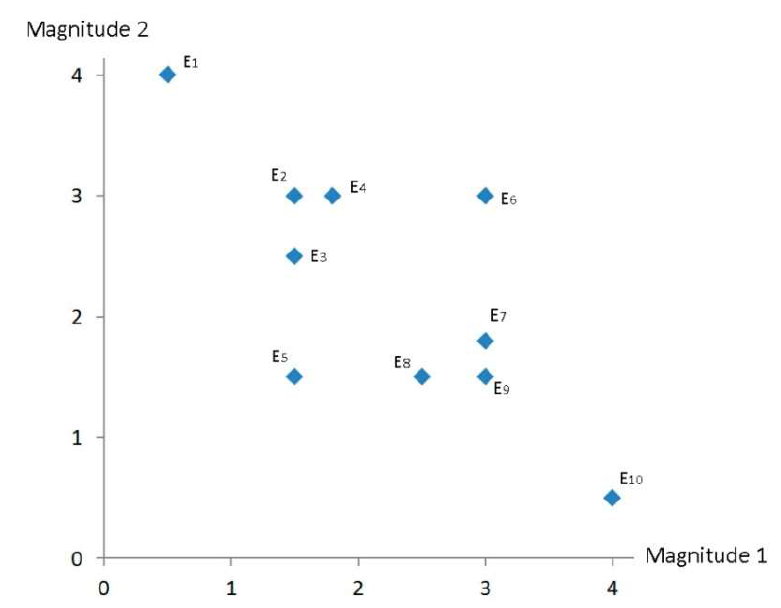
Figure 1. Graphical representation of the ten firms in Table 1 (E 1 to E 10 ).